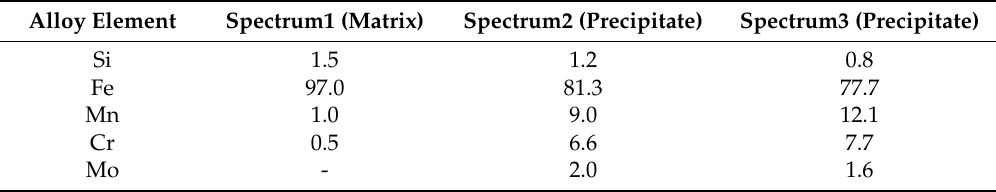
Figure 3. TEM micrographs of precipitates in the fine grain region; ( a ) distribution of precipitates; ( b ) rectangular precipitate; ( c ) circular precipitate. Table 1. The results of EDS analysis of precipitates and matrix (wt %).